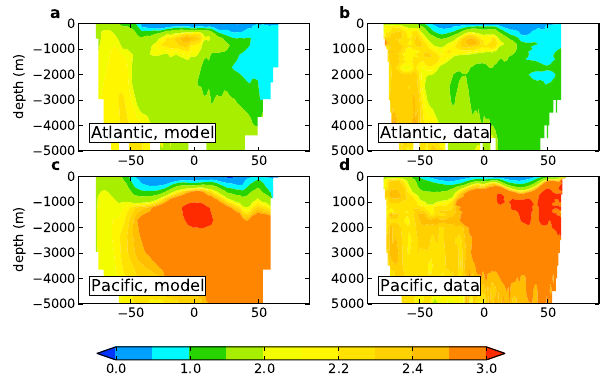
Figure 10. Zonal average of the phosphate distribution in the ocean (µmolkg − 1 ). Data from the World Ocean Atlas 2009 (Garcia et al.,